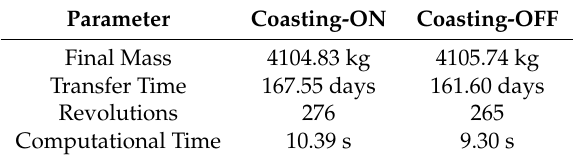
Table 2. Algorithm performance comparison for coasting ON/OFF modes for Sub-GTO to GEO